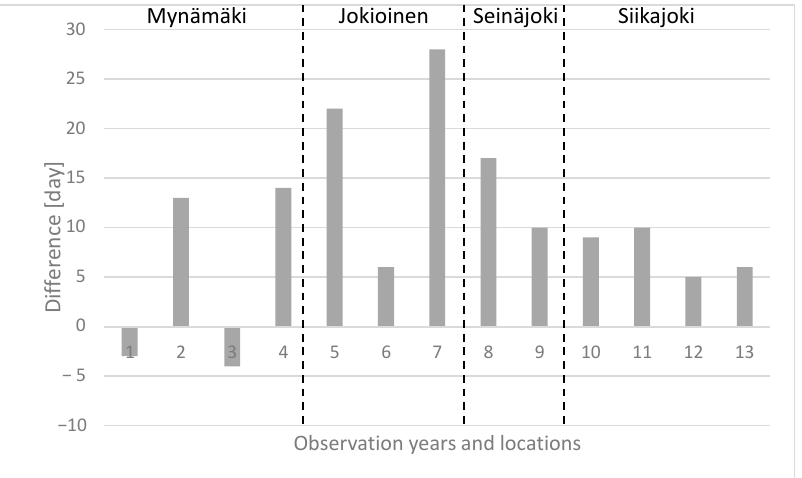
Figure 3. Difference between the sowing date and the beginning of the growing season, presented by year (running number on x-axis) and observation fields (names).